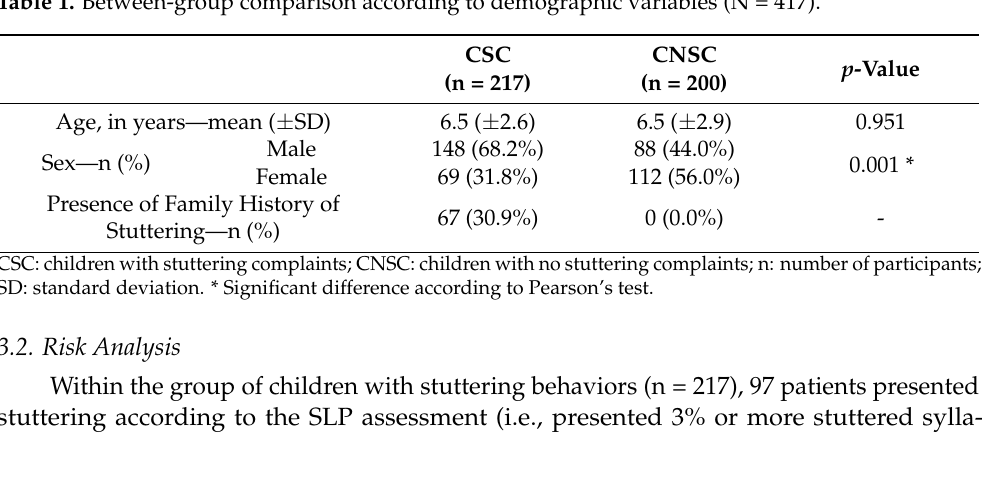
Table 1. Between-group comparison according to demographic variables (N =